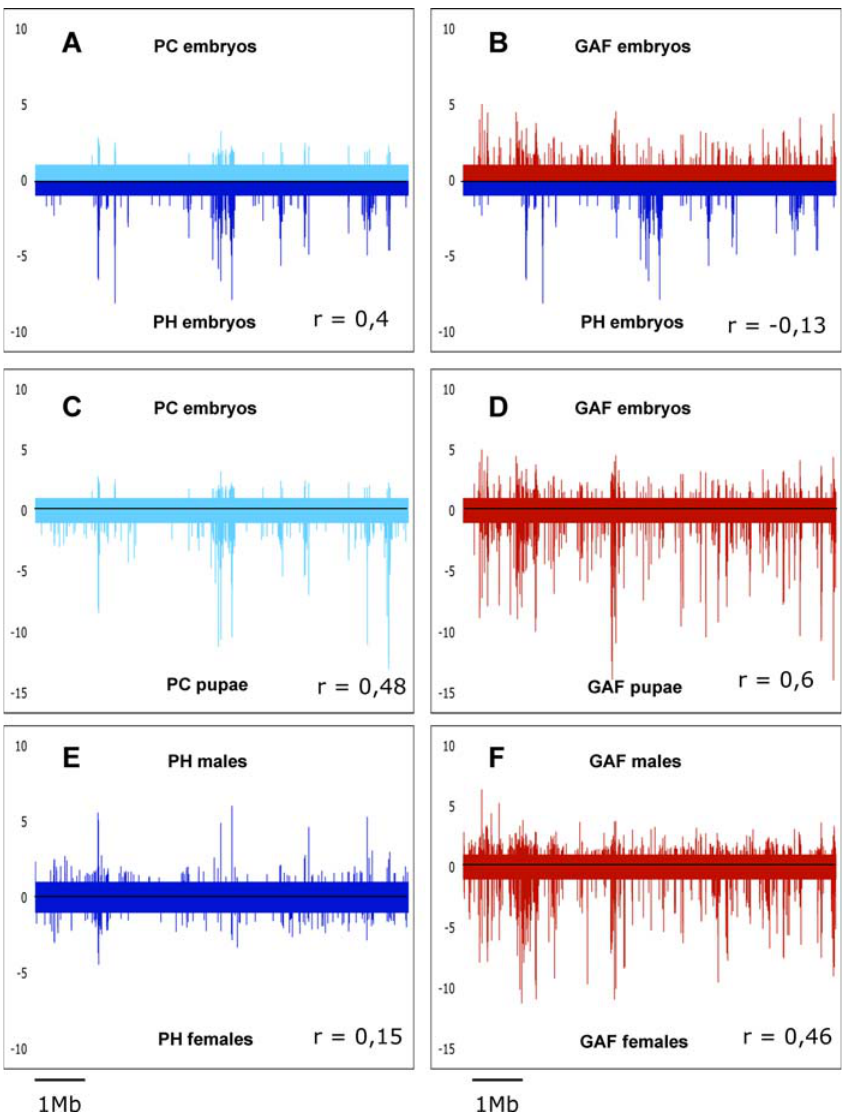
Figure 4. Developmental Comparison of the Distribution Profiles of PC, PH, and GAF PC is shown in light blue, PH in blue, and GAF in red. All signals that are not significantly enriched are set to one in these graphs. Thus, only the significant targets detected by RDAM at FDR 10% are shown. The correlation coefficient for each comparison is indicated above the graph. (A) A comparison between PH and PC at the embryonic stage shows the extensive overlap between the two proteins. (B) A comparison between GAF and PH in embryos shows the fundamentally different distribution profile for the two proteins. (C) Comparison between the distributions of PC in embryos over PC in pupae. (D) Comparison between the distributions of GAF in embryos over GAF in pupae. (E) Comparison between the distribution of PH males versus PH in females. (F) Comparison between the distributions of GAF in males versus GAF in females. DOI: